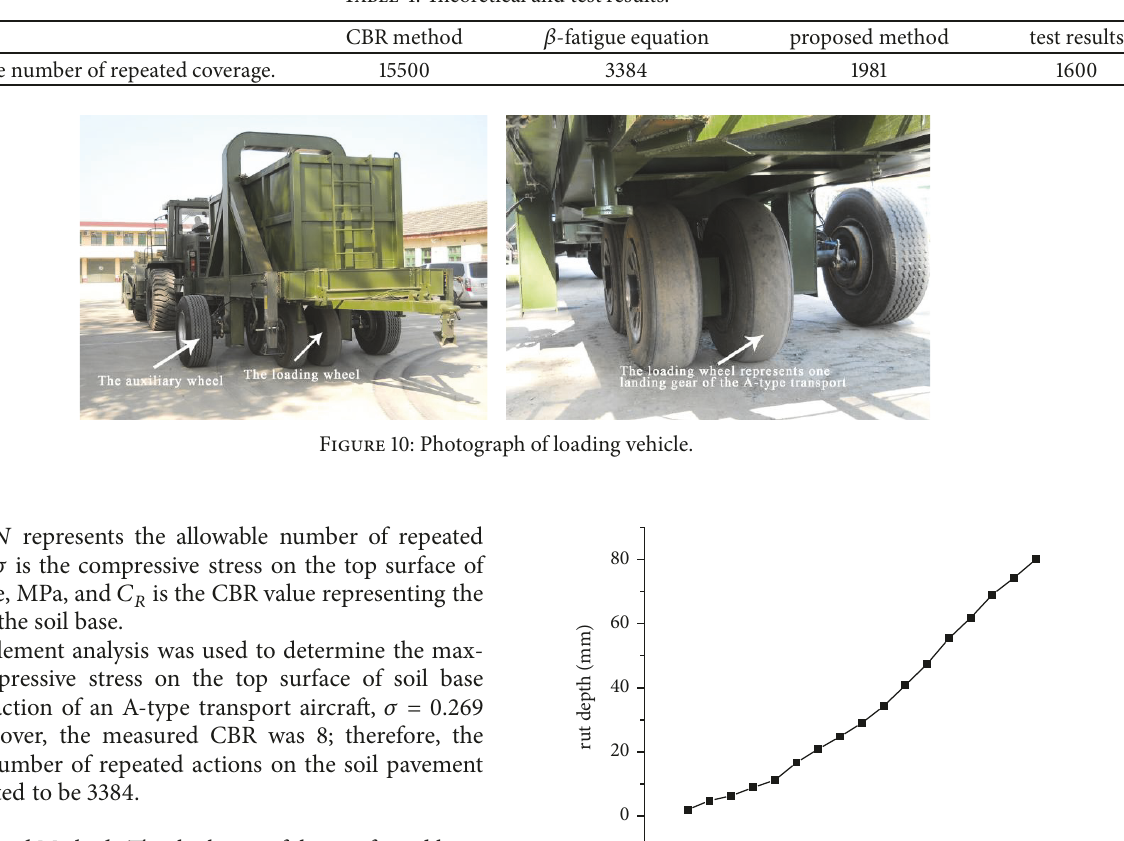
Table 4: Theoretical and test results.